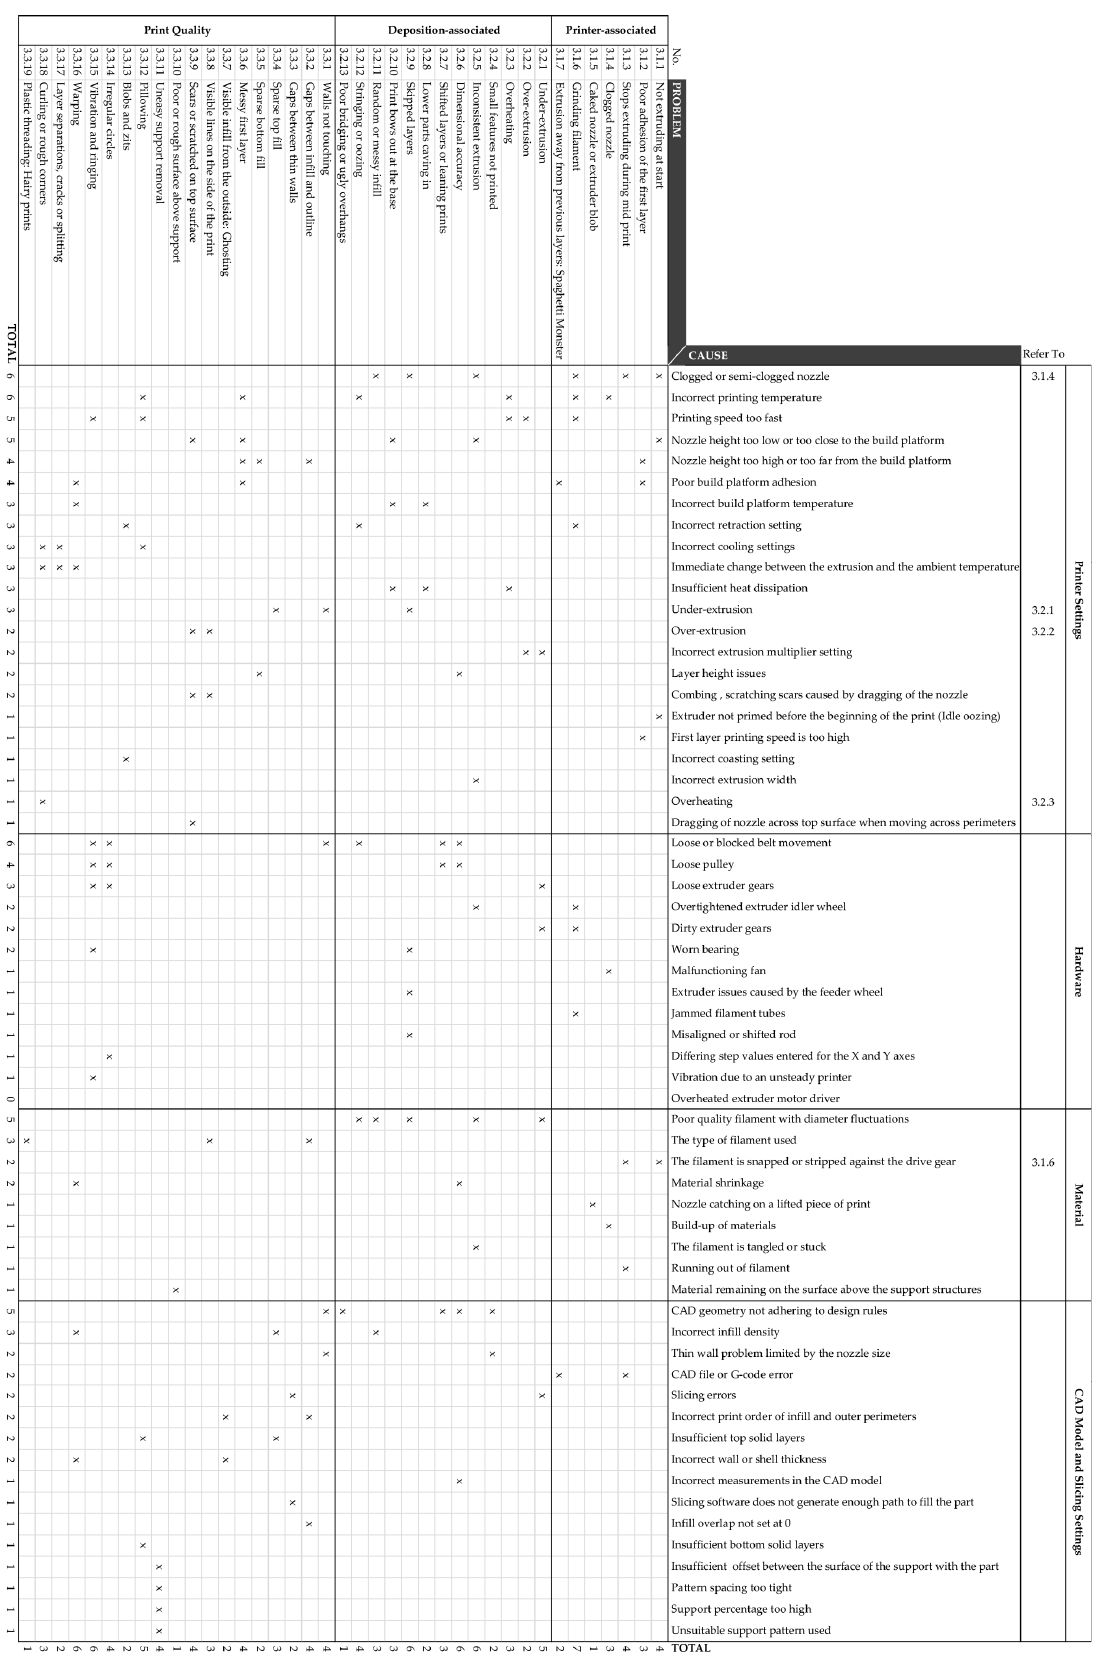
Figure 14. The most common problems of ME processes and their causes.